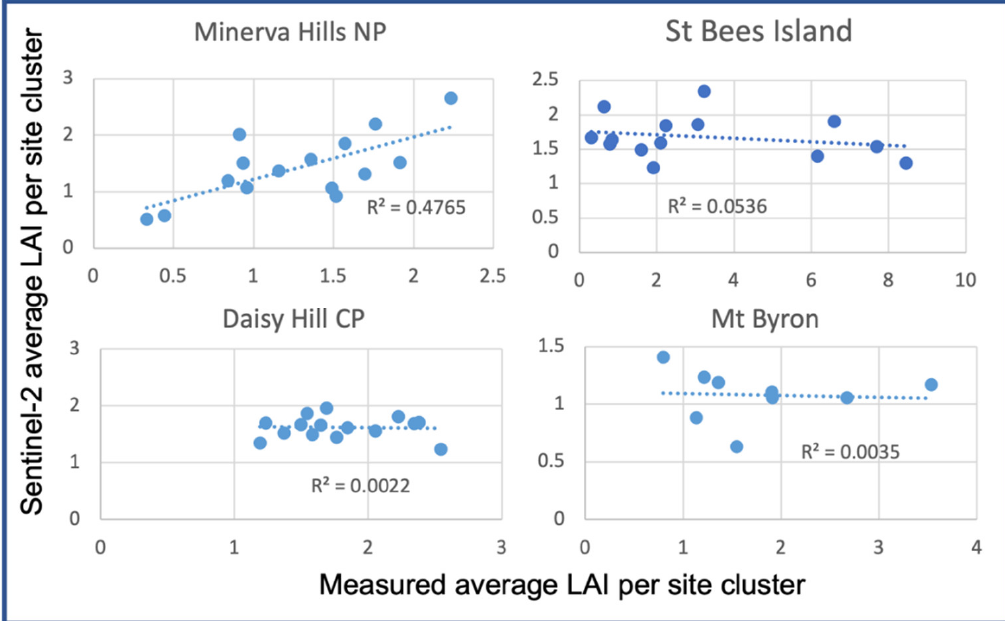
Figure A3. Comparing field measured and Sentinel-2 clusters LAI.